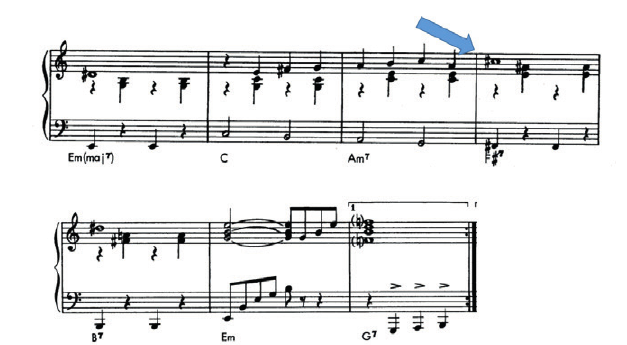
Figure 2. The deceiving cadenza for the turn-around from section B back to A (source: created by the